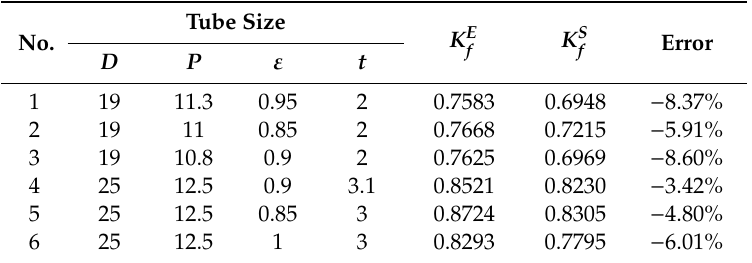
for the SG tubes. f